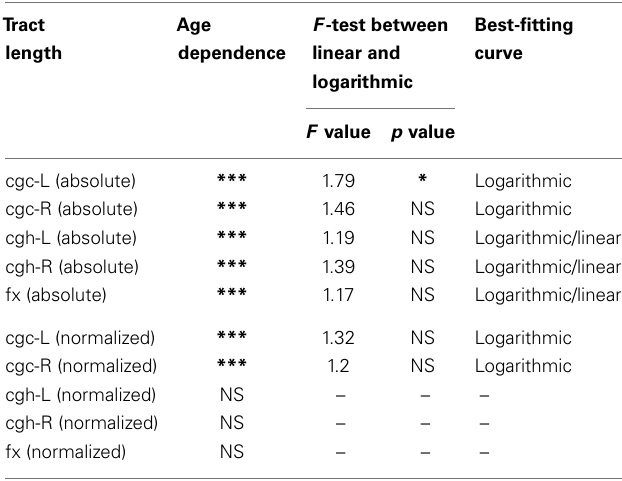
Table 6 | Relationship between limbic tract length (absolute and normalized) and age .